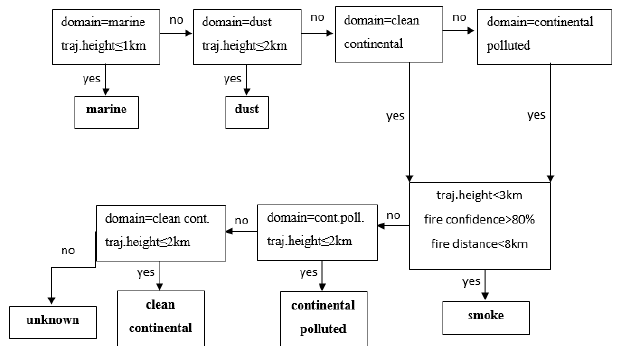
Figure 2. Classification procedure of SCAN. This procedure is per- formed for each hour of the HYSPLIT back trajectory associated with each